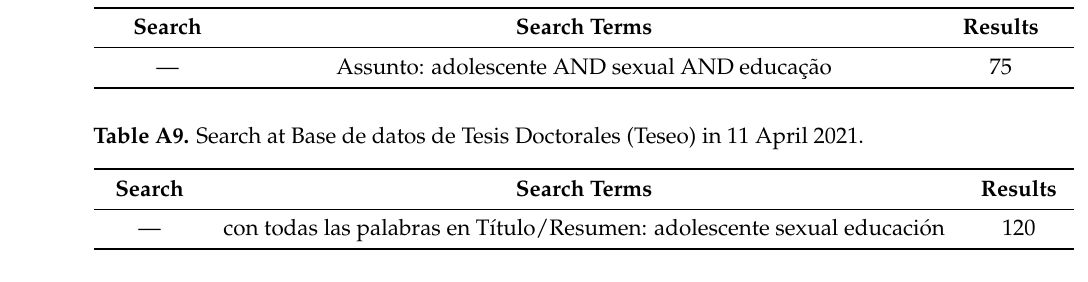
Table A10. Search at TDX (Theses and Dissertations Online) in 11 April